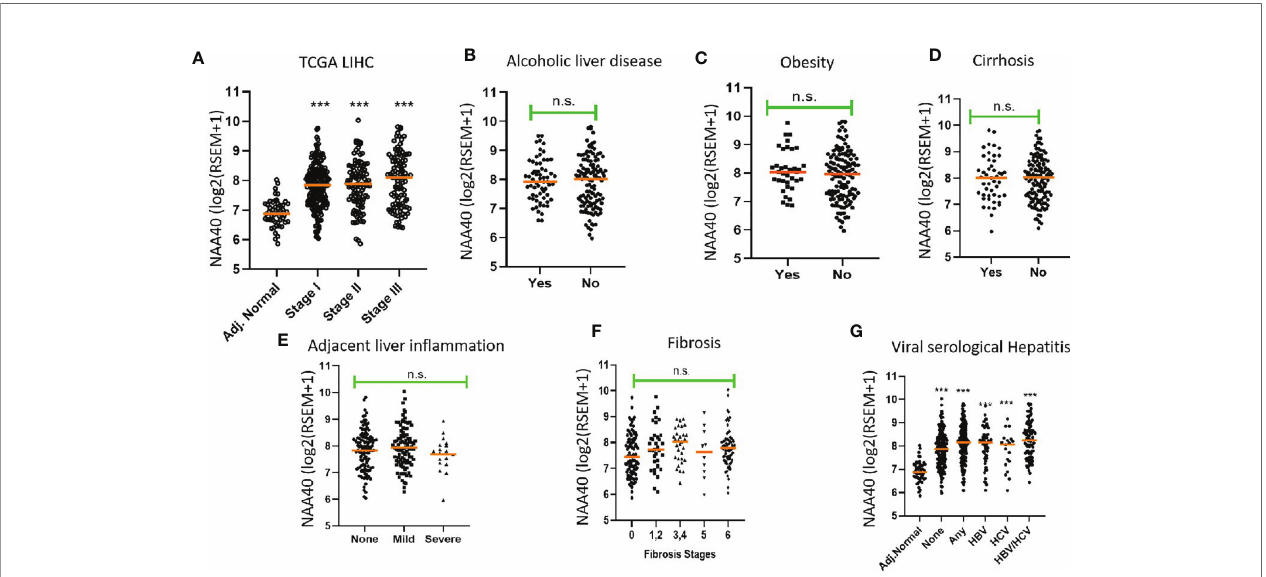
FIGURE 1 | Association of NAA40 expression with LIHC tumour stages and exposure to speci fi c risk factors (A) NAA40 transcript levels in adjacent normal and stages I-III of LIHC derived from the TCGA cohort. Stage IV is not shown due to small sample size; (B – G) Association between NAA40 transcript levels and various etiological factors of LIHC. In the scatterplots each circle represents an individual sample and orange line depicts the median value. NAA40 expression values shown are pan-cancer normalised log2(RSEM+1). For panel (G) Adjacent normal (Adj.norm) refers to non-cancer tissue sampled adjacent to the tumour tissue, none refers to LIHC tumour samples with no serological evidence of viral infection, any refers to LIHC samples with serological evidence with infection with either one or both hepatitis B and C Statistical signi fi cance was tested by Student ’ s t-test or one-way ANOVA ***p < 0.01. n.s., non signi fi cant.